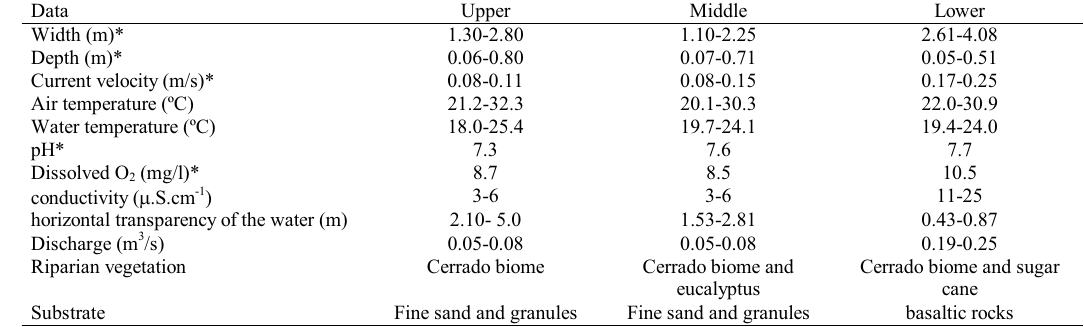
Table 1. Environmental data obtained for the three studied stretches of the Paulicéia stream. Minimum and maximum values of discharge represent the dry season and rainy season, respectively. * -